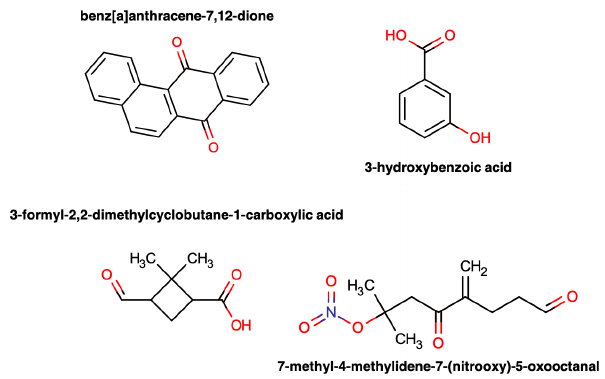
Figure 3. Examples of molecules containing carbon that are not detected by the measured set of